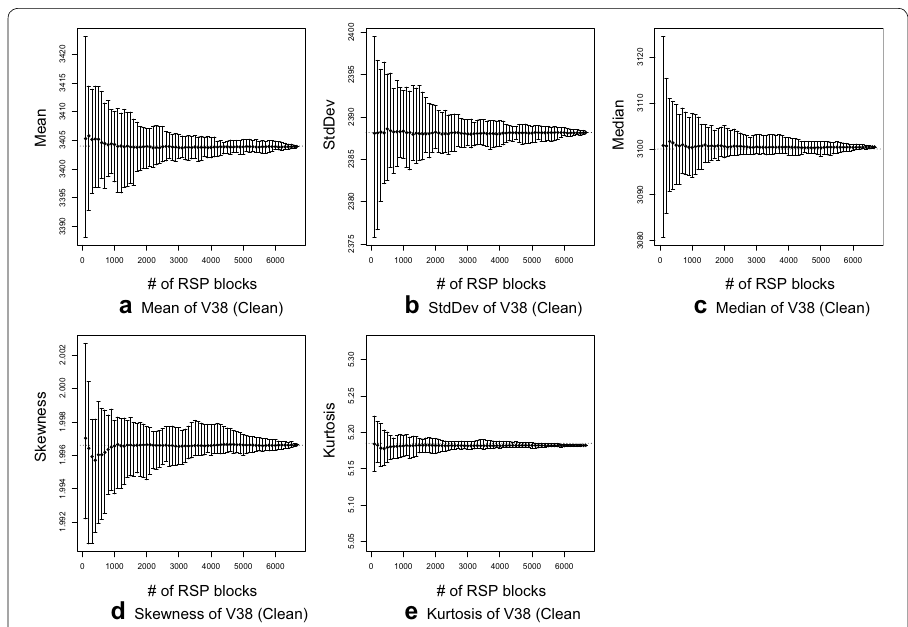
Fig. 12 Summary statistics of V38 in clean Power data. Incremental estimation of summary statistics of V38 using samples of clean RSP blocks of Power data ( g = 100 )